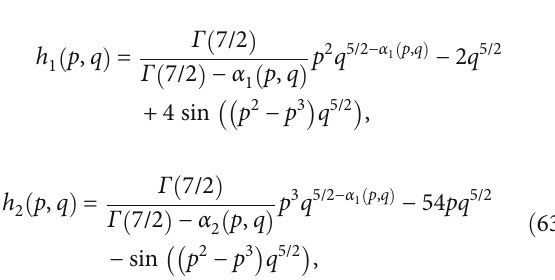
Figure 7. An image of the absolute error for value m = 6 is shown in Figure 8, and numerical results for absolute error for di ff erent values m are shown in Tables 10 – 12. Table 12 shows the comparison between the maximum absolute error (MAE) given for di ff erent values of m based on the present and the Chebyshev cardinal function (CCF)